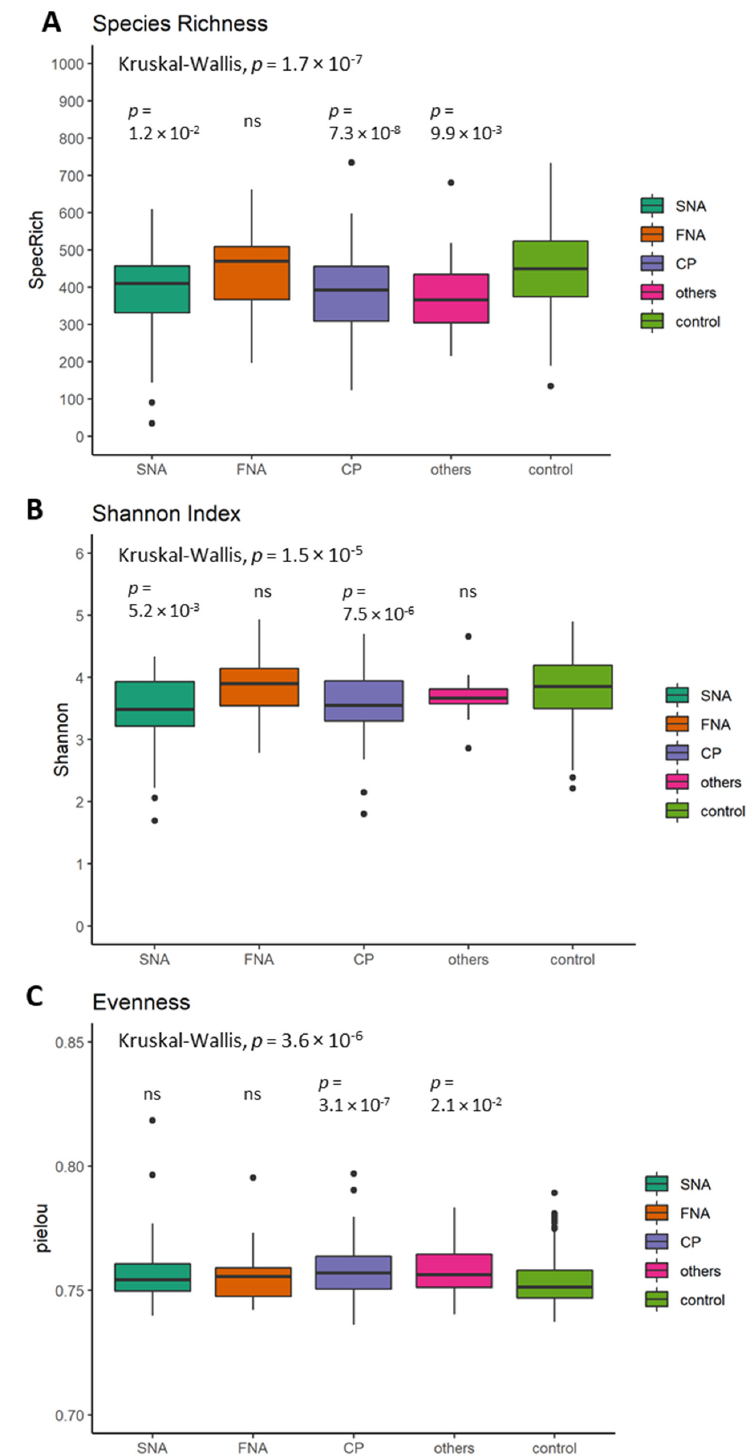
Figure 3. Alpha diversity and evenness differences between neurological subgroups and controls displayed through three indices ( A ) species richness, ( B ) Shannon index and ( C ) evenness (Pilou); (spot = outlier, overall and pairwise significance was tested by Kruskal–Wallis and Wilcoxon test (reference group = control); p < 5 × 10 − 2 ). SNA: structural neurological abnormalities; FNA: functional neurological abnormalities; CP: chronic pain and others (= these probands gave information on the presence of neurological symptoms for which the diagnostic work-up was not completed at the time of answering the FoCus